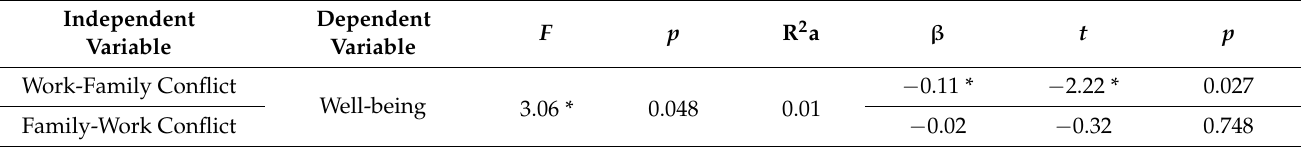
Table 5. Multiple linear regression results (H2).